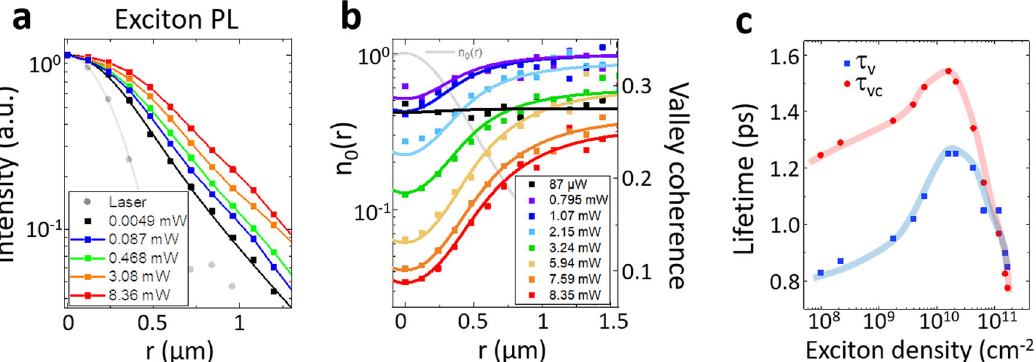
Fig. 4 Spatial dependence of valley coherence at high excitation densities T = 6 K. a Normalized PL pro fi les for selected excitation powers. b Spatially resolved valley coherence for selected excitation powers. The continuous lines are obtained by fi tting with Eq. (4). Also shown is the normalized concentration pro fi le n 0 ( r ). ( c ) Extracted valley lifetime τ v and valley coherence time τ vc from the fi tting of the curves shown in ( b ). The continuous liens are a guide to the